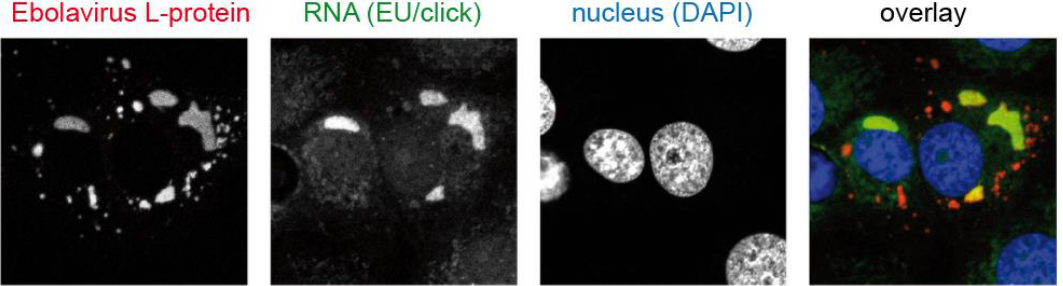
Figure 8. Visualization of ebolavirus replication compartments. Nascent viral RNA co-localizes with viral proteins in large cytosolic inclusion bodies. Modified from [93], with